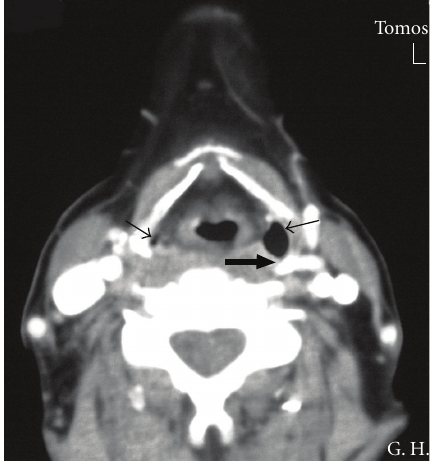
Figure 2: CT neck. Axial cut with contrast at the level of C5 vertebra. Rotation of thyroid cartilage, black arrow shows the left thyroid cornu. The airfilled cavity next to the left thyroid cornu is the left piriform sinus which is clearly bigger than the right one due to the rotation of the larynx (black thin